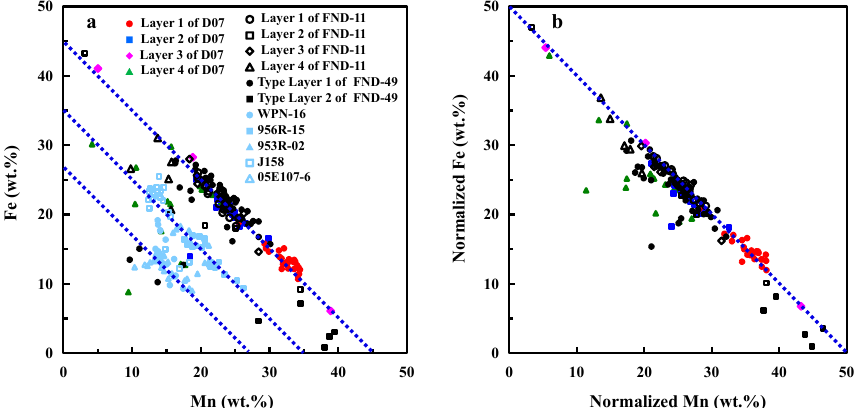
Figure 6. ( a ): Scatter plot for Fe vs. Mn; ( b ): Scatter plot for normalized Fe vs. normalized Mn. The element contents from other literature were obtained through whole rock analysis [3–5,25].